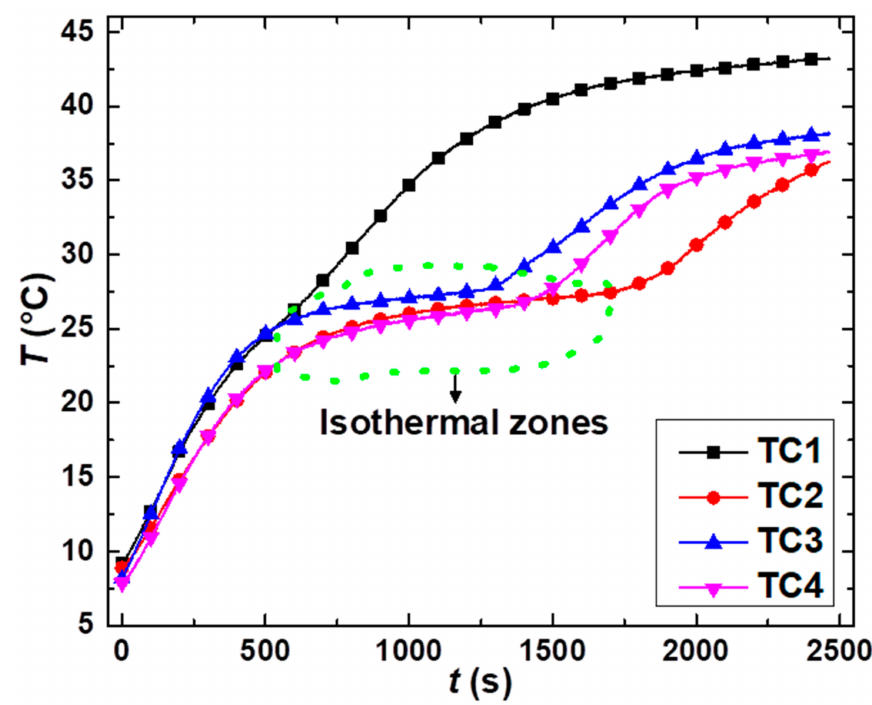
Figure A2. Transient thermal analysis of non-optimal thermal composites